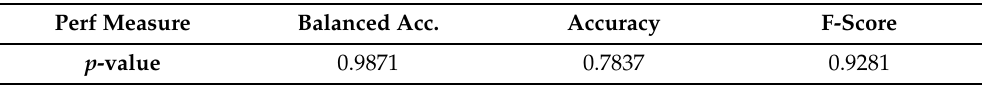
Table 4. Statistical comparison of our results based on performance measures for each data-set. Perf Measure